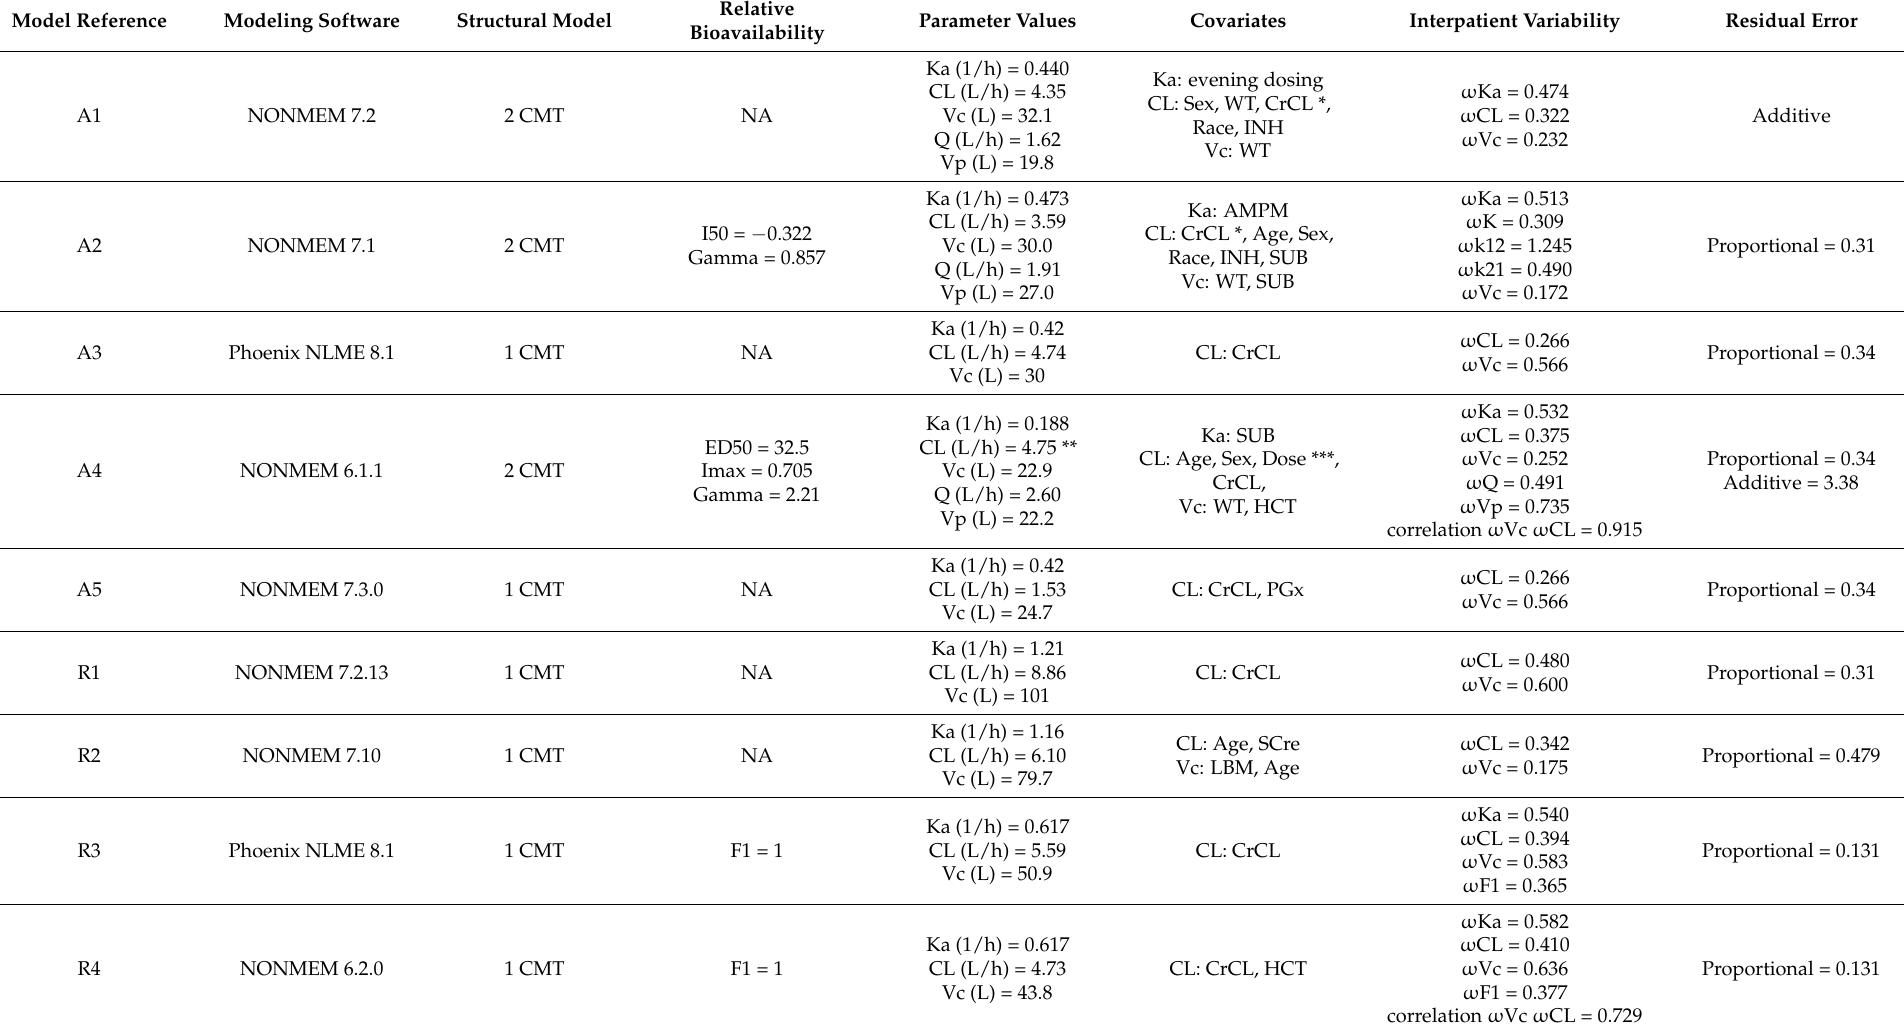
Table 2. Details of the published population pharmacokinetic